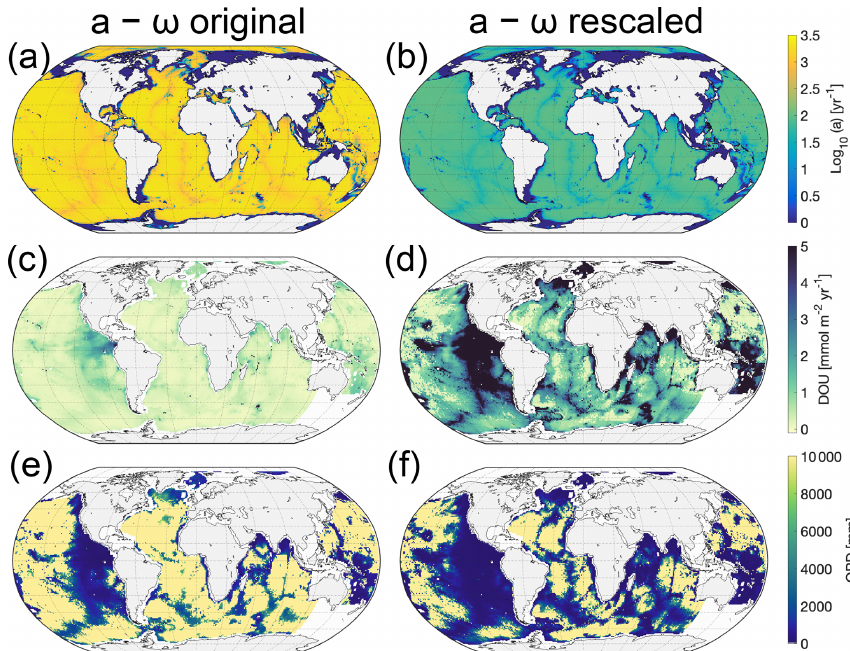
Figure 5. (a) RCM parameter a as a function of sedimentation rate, ω , according to Eq. (13), log 10 (a) = 3 . 35–14 . 81 · ω and (b) and using the same relationship with the resulting parameter linearly rescaled to fall within the range a = [1–100] years. (c, d) Global map of simulated DOU for the parameterizations shown in panels (a) and (b) . Positive fluxes are directed into the sediments. (e, f) Global map of simulated OPD for the parameterizations shown in panels (a) and (b) . Yellow areas indicate that oxygen flows across the bottom of the model domain (i.e. 10m). White indicates areas where surface sediment OM contents are not available, i.e. most coastal margins and the south-west Pacific (see Seiter et al., 2005). We omit these grid cells in our